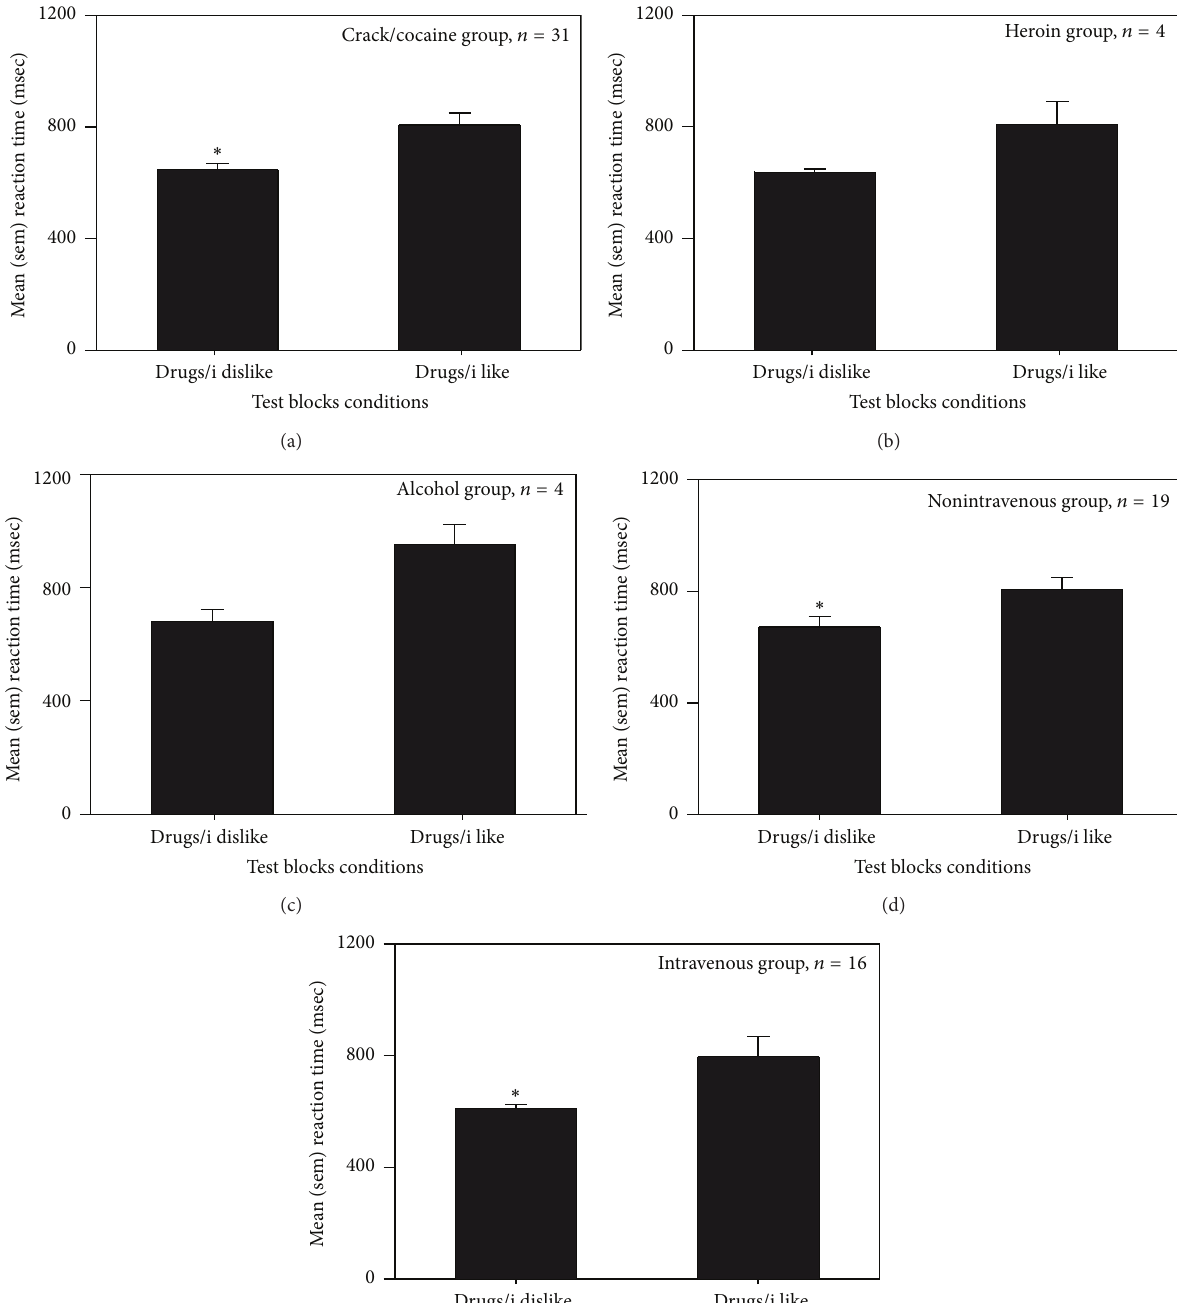
Figure 4: IAT performance of volunteers tested at Stonehenge Therapeutic Community. Mean and sem reaction times (msec) on test trials comparing “drugs” and “I dislike” versus “drugs” and “I like” in groups created on the basis of drug of choice or preferred route of administration ((a) = crack/cocaine, (b) = heroin, (c) = alcohol, (d) = non intravenous; and (e) = intravenous). The ∗ indicates a significant difference within